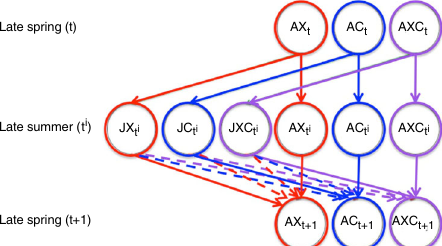
Fig. 5 Model of song development. We used two age classes (J = juvenile and A = adult) and three classes of introductions (C = click trains, X = high note clusters, and XC = both). In the late spring of a given year (time = t), only adult males are present. In late summer, those adults have bred and both they and juvenile males are present; at this intermediate time (t i ) each male is initially allocated the same introduction type as his father (solid lines). Then, as song development progresses and juvenile males can be in fl uenced by other tutors, they may retain their initial introduction type or switch to either of the other two types (dashed lines) before they crystallize their songs late in the following spring (time = t + 1), and join the breeding cohort, which also includes adult males from the previous year who returned to breed